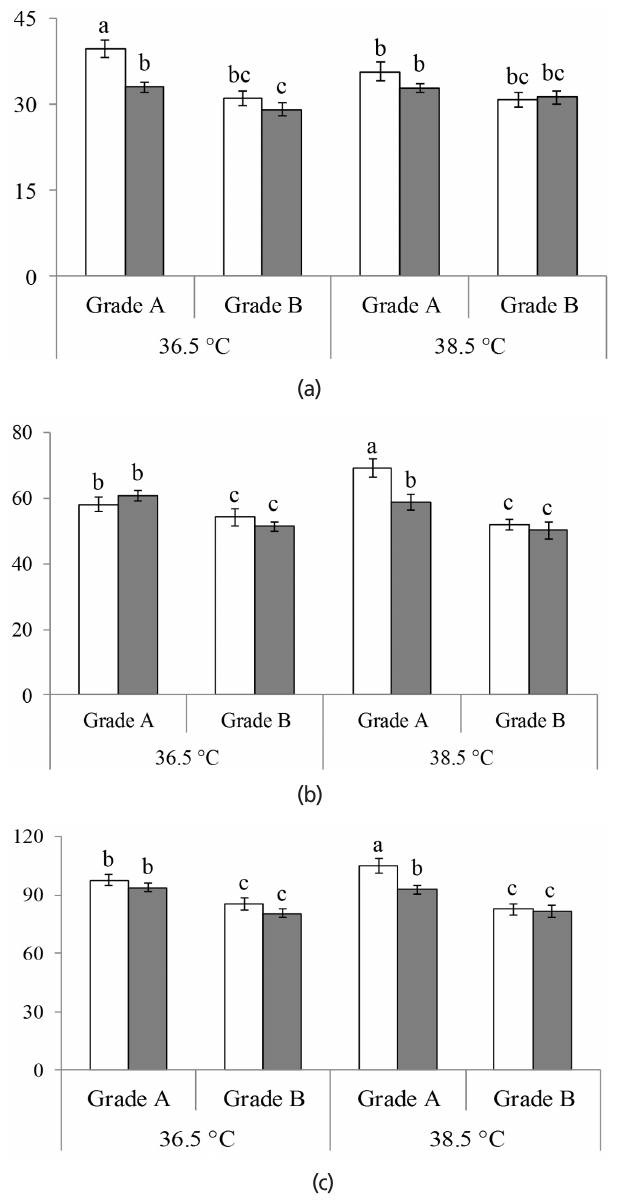
Figure 1. Effect of temperature during in vitro maturation and antioxidants in embryo culture on inner cell mass (a), trophectoderm (b), and overall (c) cell numbers of blastocysts from Grade A or Grade B oocytes matured at either 36.5°C (n = 152) or 38.5°C (n = 165). The error bars represent the standard error of means and bars with different letters are significantly different at p<0.05. The white bars represent the embryo culture media with antioxidants, whereas the gray bars represent the antioxidants free media.